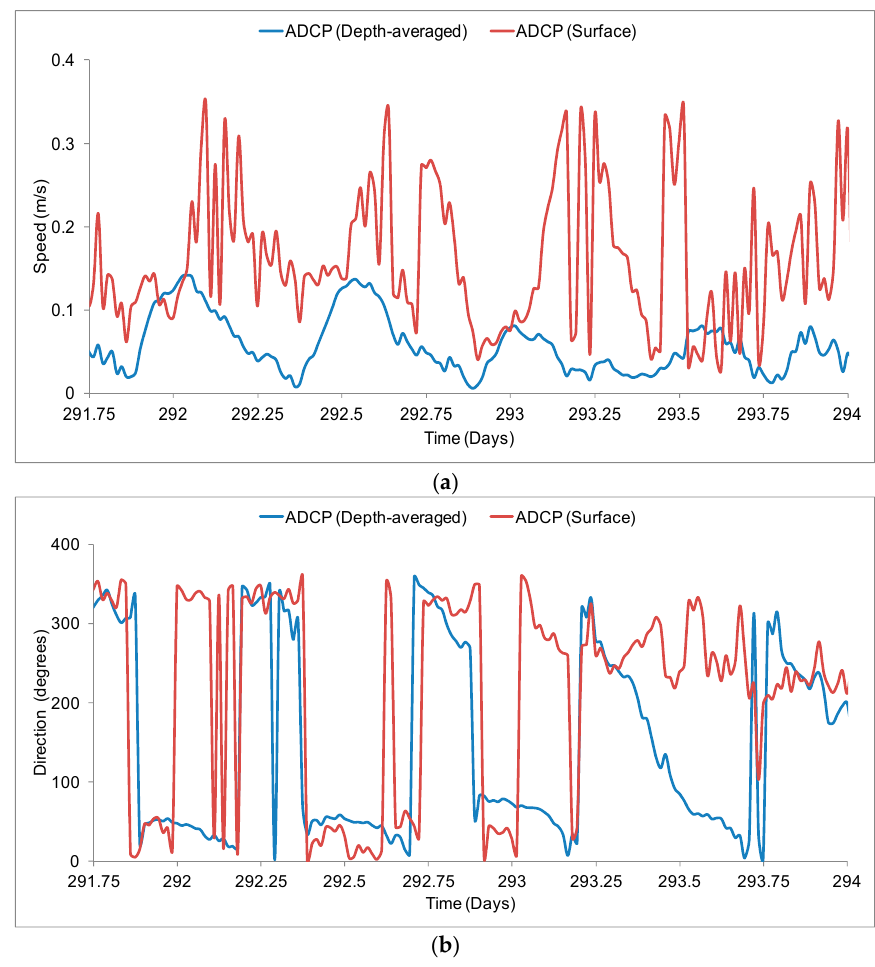
Figure 7. Depth-averaged and surface ADCP data for ( a ) speed ( b ) direction at A2 during P1.